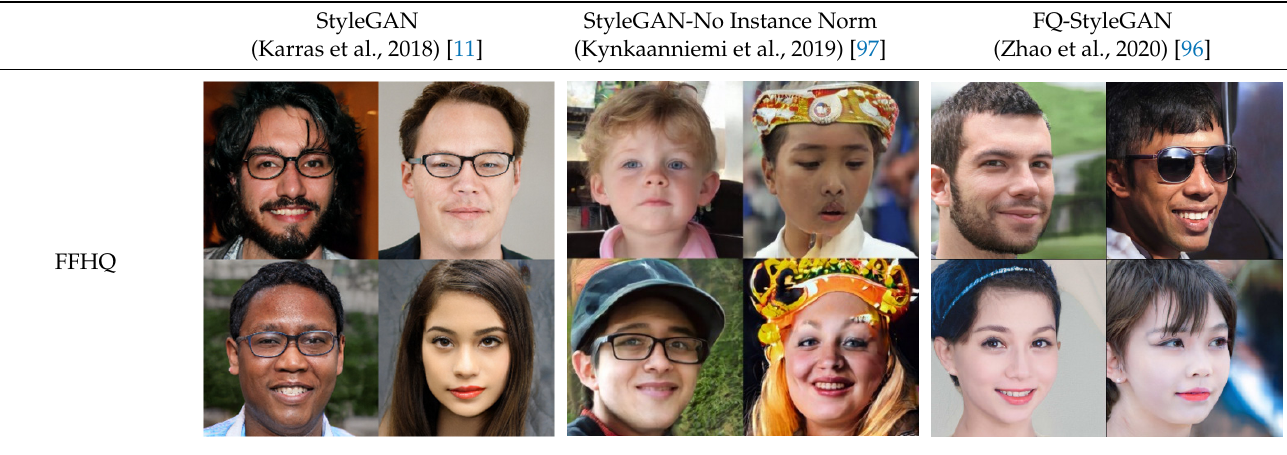
Table 6. Visual results of different models trained with the FFHQ higher resolution image dataset. More results are presented in that